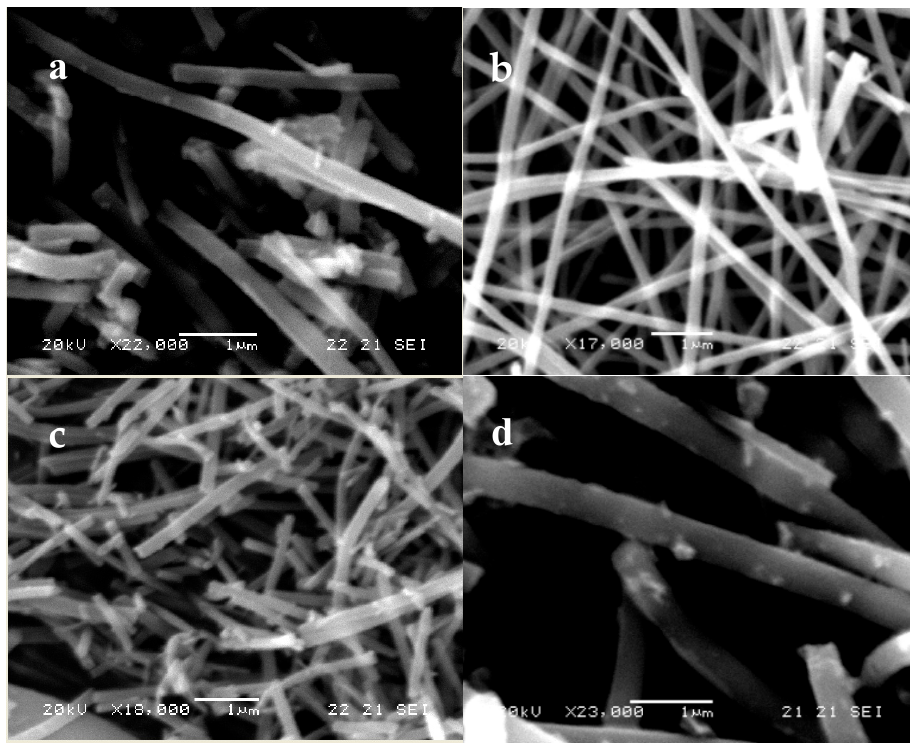
Figure 4. SEM images of electrospun fibers after calcination ( a ) TiO 2 , ( b ) GNT1%, ( c ) GNT2.5%, ( d ) GNT5%.